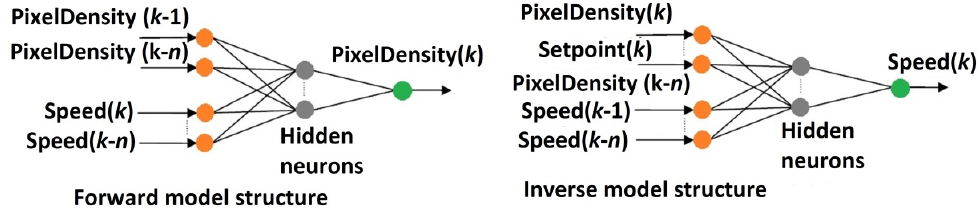
Figure 11 . Schematic of the forward and inverse neural model (inverse model = controller). Figure 11. Schematic of the forward and inverse neural model (inverse model =